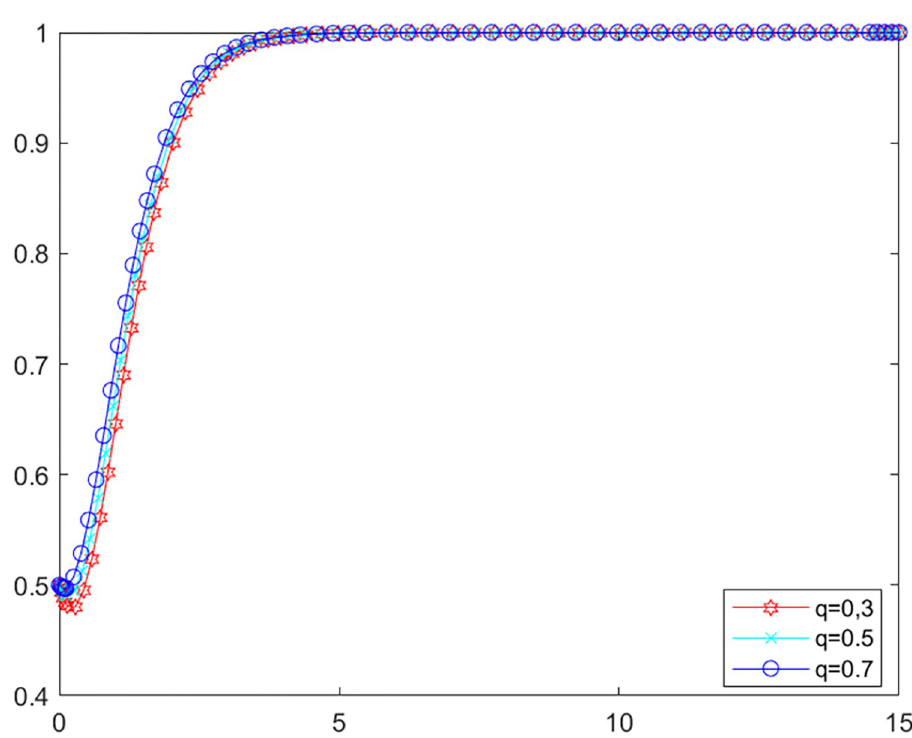
Fig 7. LPBE’s evolutionary